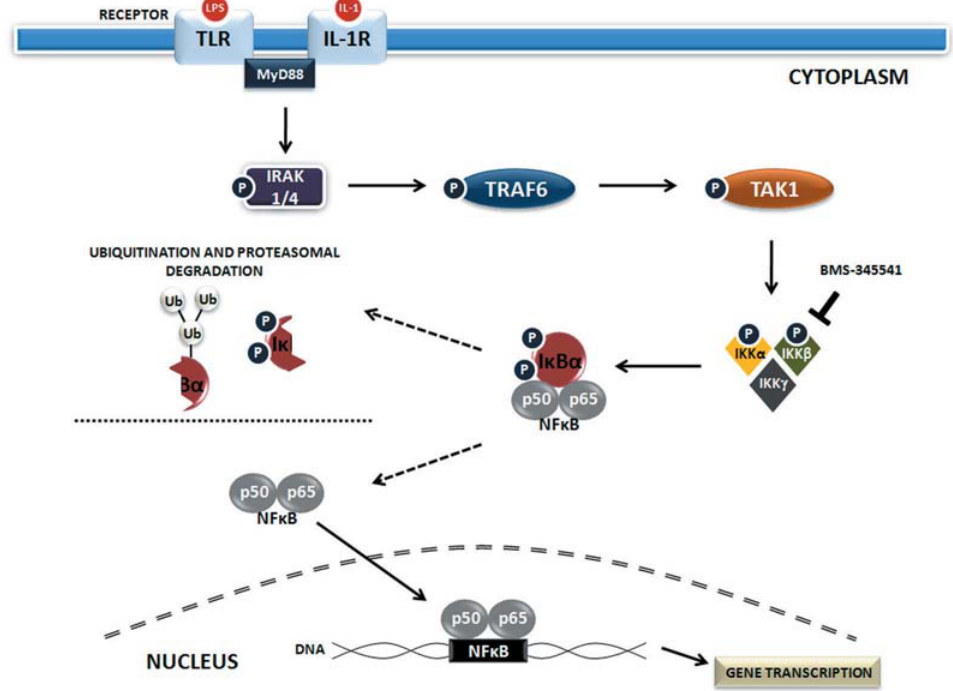
Figure 2- (cid:7)&%"’*(cid:7)(cid:15)(cid:19)(cid:12)(cid:16)<(cid:19)(cid:18)(cid:30)(cid:7)=’*(cid:6)(cid:7)(cid:29)(cid:13)(cid:14)(cid:24)(cid:7)(cid:12)(cid:17)(cid:7)(cid:20)(cid:10)(cid:14)(cid:21)(cid:12)(cid:13)(cid:17)(cid:14)(cid:19)(cid:11)(cid:7)&%">*(cid:7)(cid:12)(cid:8)(cid:19)(cid:14)(cid:6)(cid:21)(cid:8)(cid:13)(cid:15)(cid:12)(cid:13)(cid:17)(cid:14)(cid:7)(cid:20)(cid:19)(cid:21)(cid:12)(cid:17)(cid:8)(cid:6)(cid:7)?(cid:15)IOQ(cid:15)VOW(cid:7)(cid:13)(cid:14)(cid:7)(cid:21)(cid:18)(cid:12)(cid:17)(cid:15)(cid:11)(cid:19)(cid:6)(cid:23)(cid:7)(cid:13)(cid:14)(cid:7)(cid:19)(cid:29)(cid:6)(cid:9)(cid:14)(cid:21)(cid:9)(cid:7)(cid:17)(cid:20)(cid:7)(cid:6)(cid:12)(cid:13)(cid:23)(cid:10)(cid:11)(cid:13)(cid:7) and prevent their nuclear translocation. Signaling through TNF receptor (TNFR), IL-1 receptor (IL-1R), or toll-like receptor (TLR) can activate a cascade that involves the recruitment of MYD88 (myeloid differentiation primary response gene 88) and IRAK (interleukin-1-receptor associated kinase). Activation of IRAK results in the phosphorylation of TNF-receptor (cid:19)(cid:6)(cid:6)(cid:17)(cid:21)(cid:13)(cid:19)(cid:12)(cid:9)(cid:24)(cid:7) (cid:20)(cid:19)(cid:21)(cid:12)(cid:17)(cid:8)(cid:7) V(cid:7) ?$Z(cid:3)%VW!(cid:7) (cid:11)(cid:9)(cid:19)(cid:24)(cid:13)(cid:14)(cid:25)(cid:7) (cid:12)(cid:17)(cid:7) (cid:12)(cid:8)(cid:19)(cid:14)(cid:6)(cid:20)(cid:17)(cid:8)(cid:23)(cid:13)(cid:14)(cid:25)(cid:7) (cid:25)(cid:8)(cid:17)<(cid:12)(cid:16)(cid:7) (cid:20)(cid:19)(cid:21)(cid:12)(cid:17)(cid:8)"["(cid:19)(cid:21)(cid:12)(cid:13)(cid:28)(cid:19)(cid:12)(cid:9)(cid:24)(cid:7) >(cid:13)(cid:14)(cid:19)(cid:6)(cid:9)(cid:7) (cid:31)(cid:7) ?$(cid:3)(cid:5)(cid:31)W(cid:7) (cid:19)(cid:21)(cid:12)(cid:13)(cid:28)(cid:19)(cid:12)(cid:13)(cid:17)(cid:14)!(cid:7) <(cid:16)(cid:13)(cid:21)(cid:16)!(cid:7)